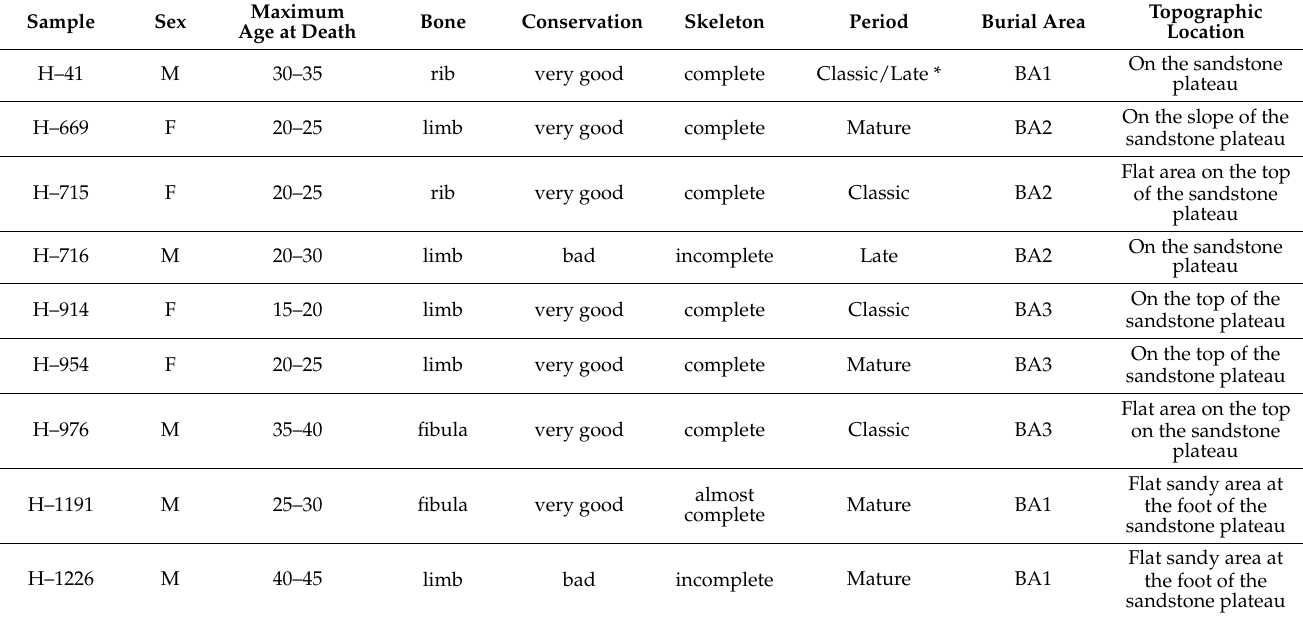
Table 1. Main features of the archaeological human bone samples collected in the Garamantian necropolis of the Fewet oasis in the Sahara of SW Libya (* From archaeological material—C14 date rejected)